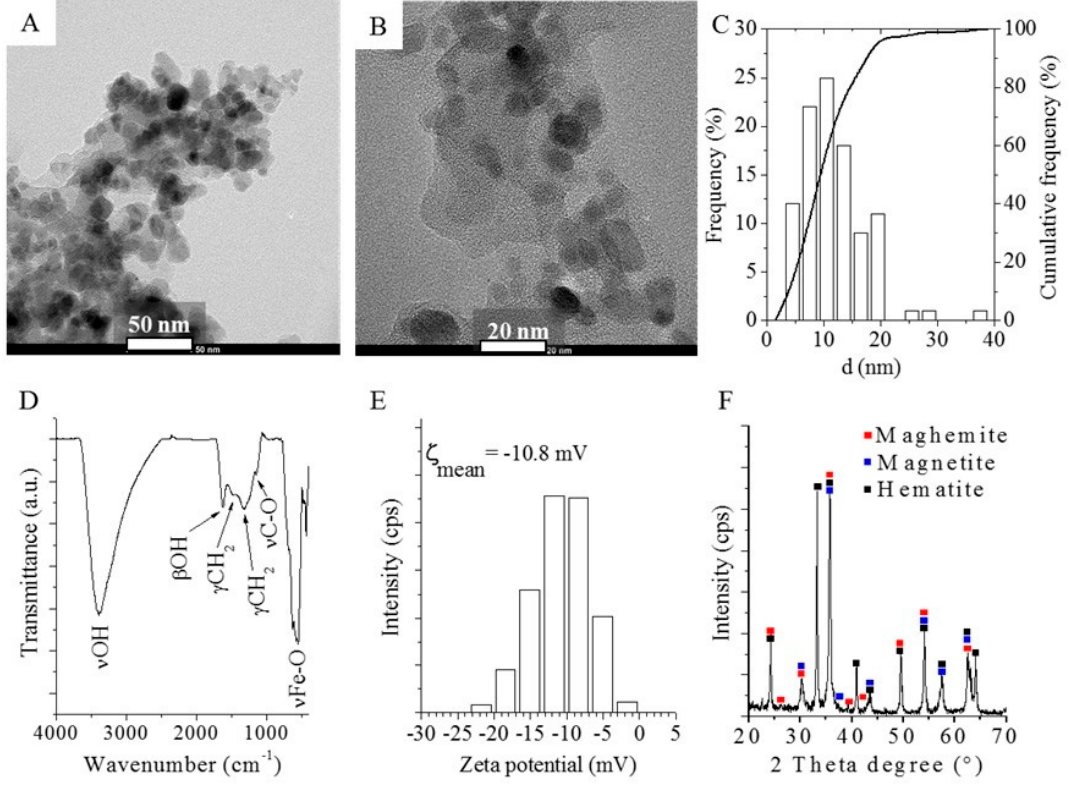
Figure 4. HRTEM images ( A , B ) and size distribution ( C ) of the magnetic nanoparticles. Fourier Transformed Infrared (FTIR) spectrum of the iron-oxide surface with the identified functional groups ( D ). Zeta potential distribution of the nanoparticles in aqueous phase ( E ) and X-ray diffraction (XRD) pattern of the iron-oxide sample ( F ).